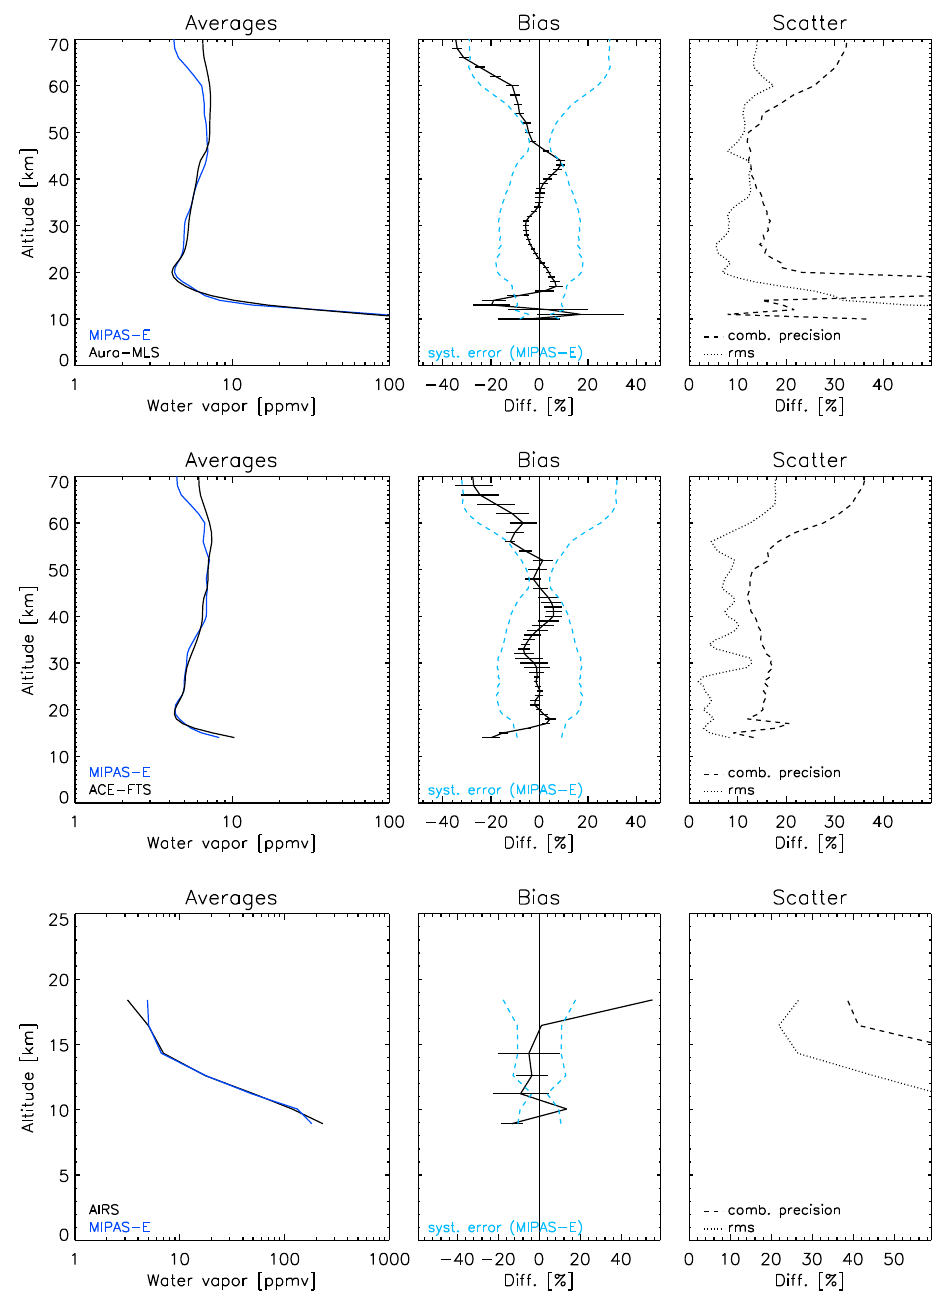
Fig. 14. Same as Fig. 9 but for water vapor profiles from Aura/MLS v3.3 (top row), ACE-FTS (middle row), and AIRS (bottom row). For a more detailed description see Fig. 9.